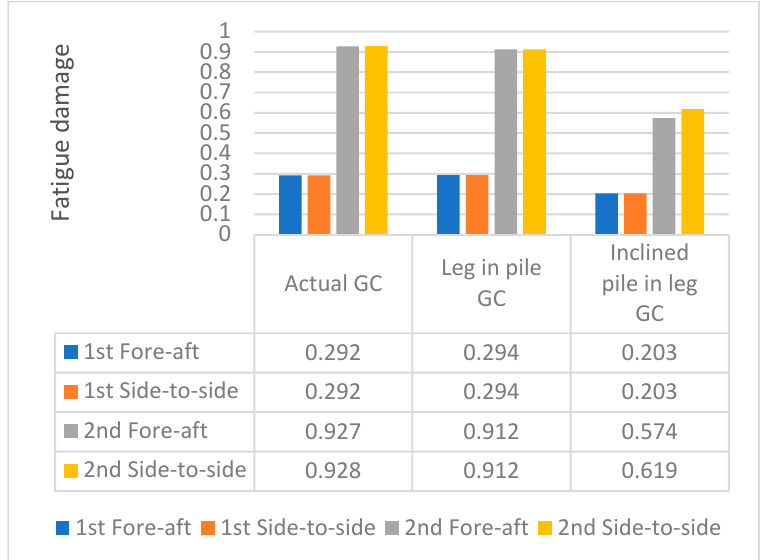
Figure 20. Types of grouted connections. ( a ) Pile in leg. ( b ) Leg in pile.